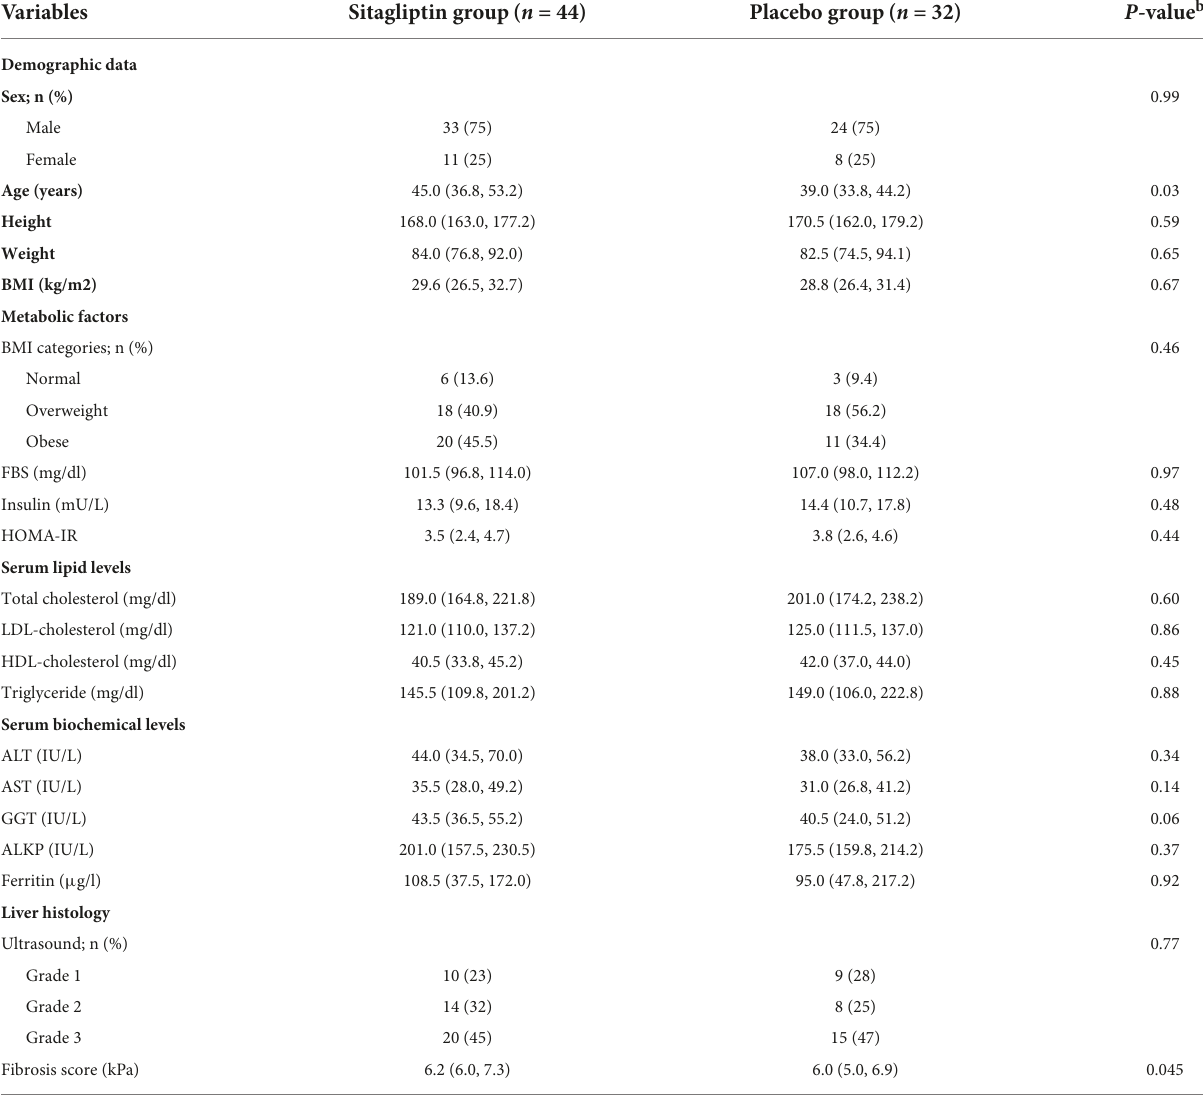
TABLE 1 Baseline demographic and laboratory characteristics of participants. a